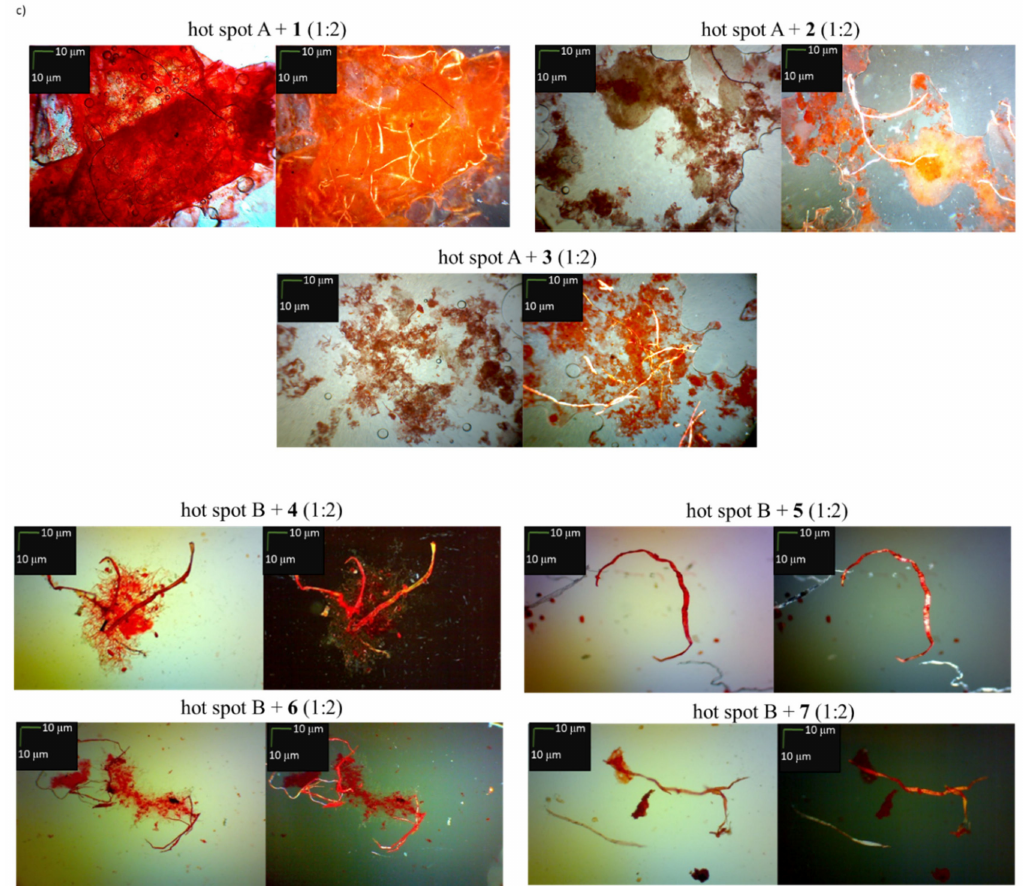
Figure 4. ( a ) UV spectra of mixtures (1:2) of hot-spot A with one of the peptides 1 – 3 and hot-spot B with one of the peptides 4 – 7 in the presence of Congo Red (CR). The spectra show results obtained on the fourth day of incubation; ( b ) fluorescence intensity spectra of mixtures (1:2) of hot-spot A with one of the peptides 1 – 3 and hot-spot B with one of the peptides 4 – 7 in the presence of Thioflavin T (ThT), wavelength = 485 nm, fourth day of incubation; ( c ) pictures of mixtures (1:2) of hot-spot A with one of the peptides 1 – 3 and hot-spot B with one of the peptides 4 – 7 , without a polarized filter (left side), with a polarized filter (right side). Scale bars, 10 µ m. In all cases, the samples were taken for microscopic examination on the fourth day of